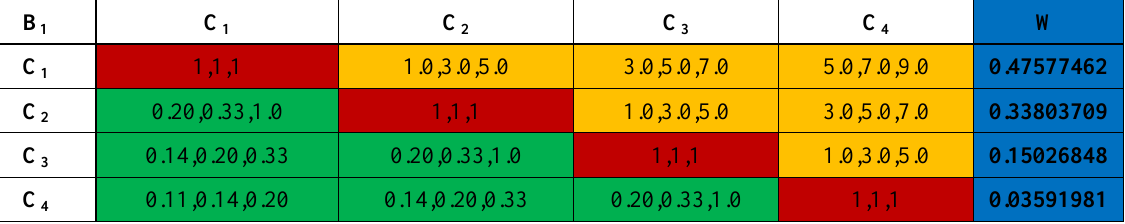
Table 5. The pairwise comparison matrix B